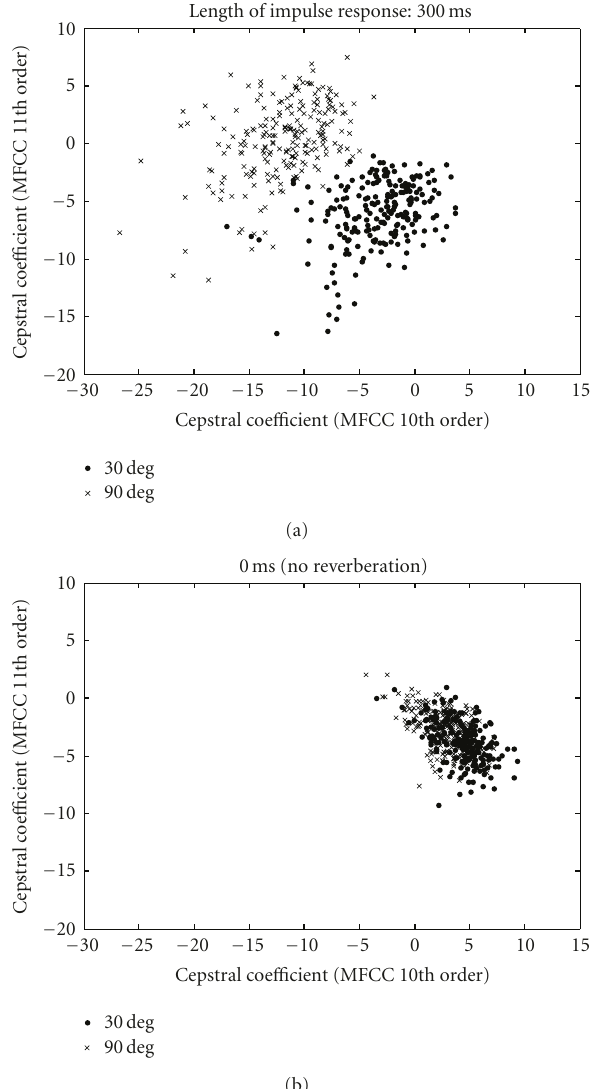
Figure 3: Di ff erence between acoustic transfer functions obtained by subtraction of short-term-analysis-based speech features in the cepstrum